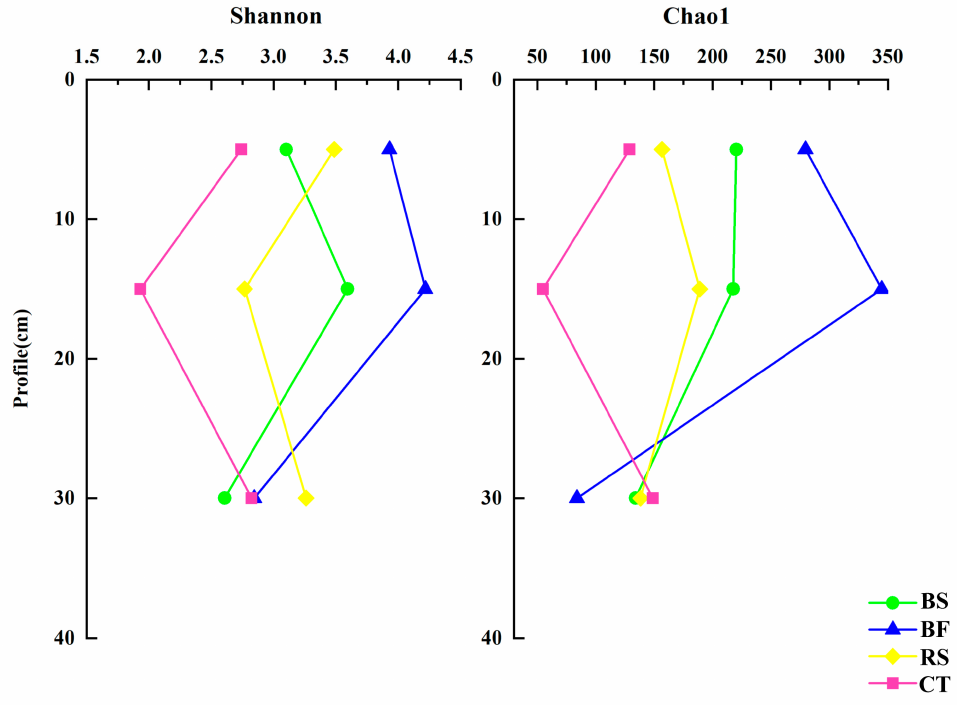
Figure 2. Diversity and richness in soil fungal communities along the soil profile under different soil and water conservation